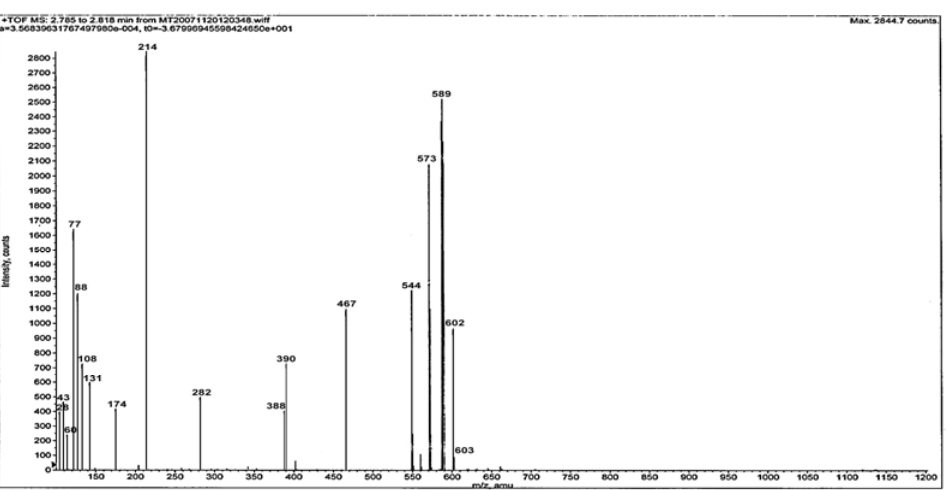
Figure 2. 1 H-NMR spectrum of the ligand